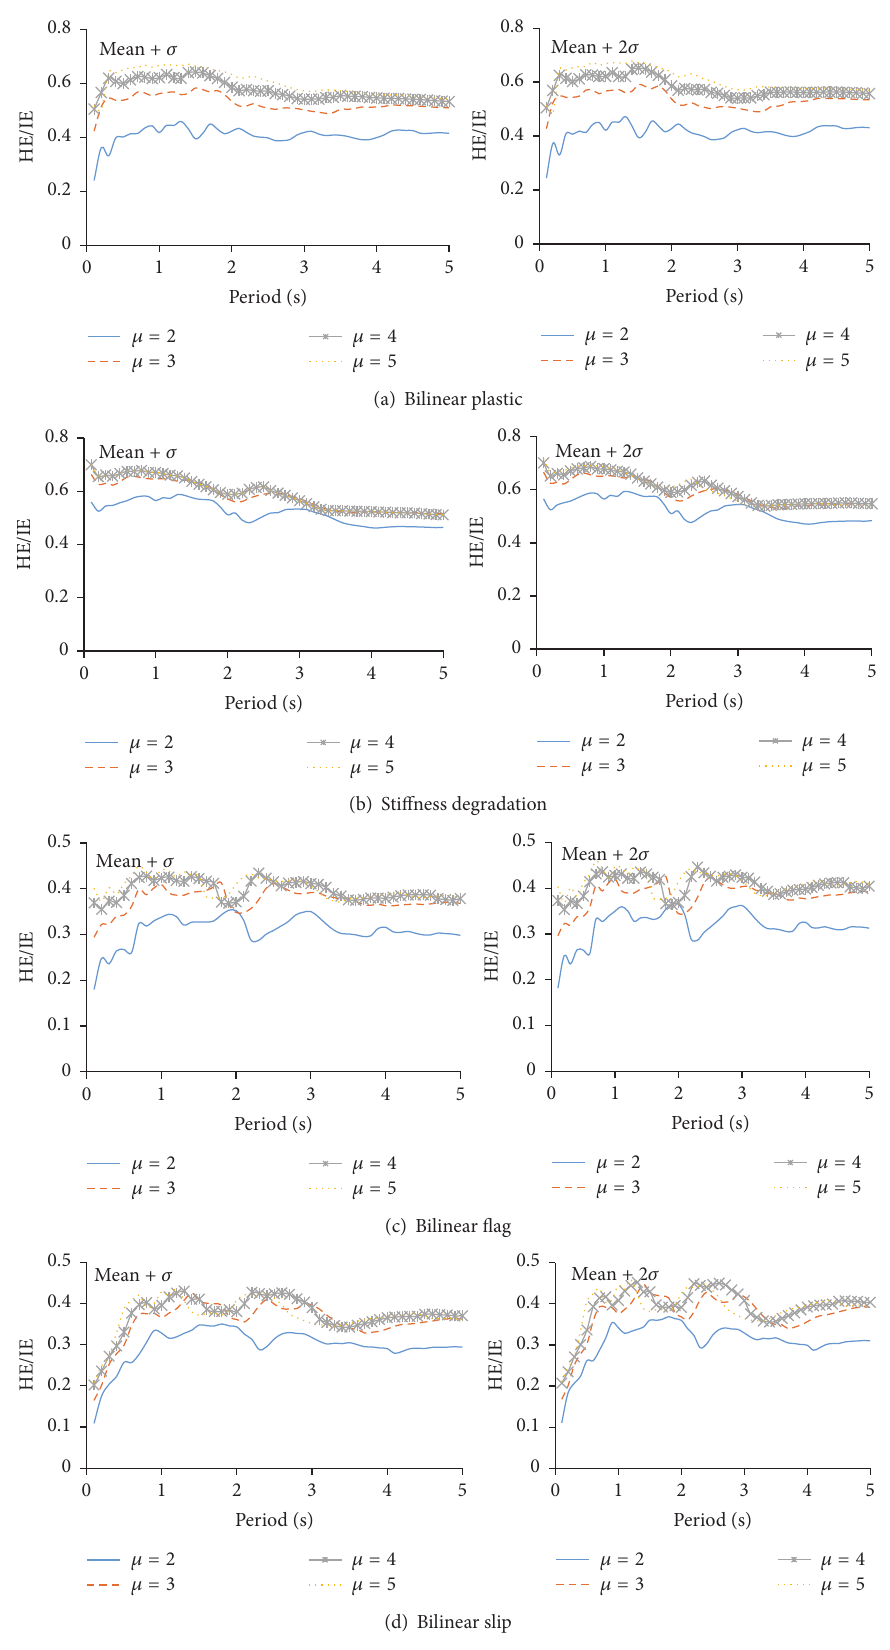
Figure 10: HE/IE spectra for soil site class